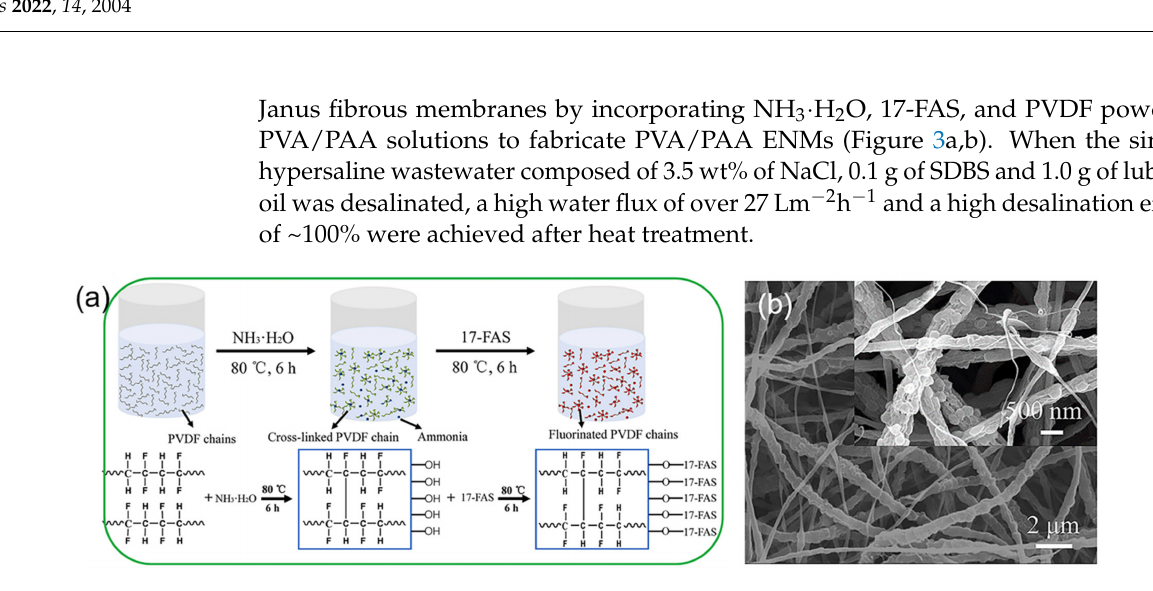
Figure 3. ( a ) Schematic illustration of PVDF chains crosslinking induced by NH 3 · H 2 O and the 17-FAS grafting onto PVDF polymer chains; ( b ) FE-SEM images of PVDF ENMs through a fluorinated, self- roughened process and thermal treatment. Reprinted with permission from Ref. [72]. 2020, Elsevier.